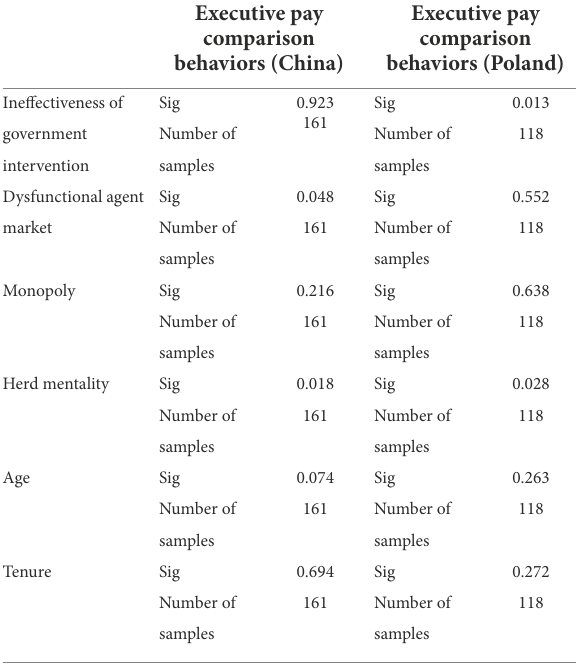
TABLE 3 The relationship between executive pay comparison behaviors and various affecting factors: OLS regression